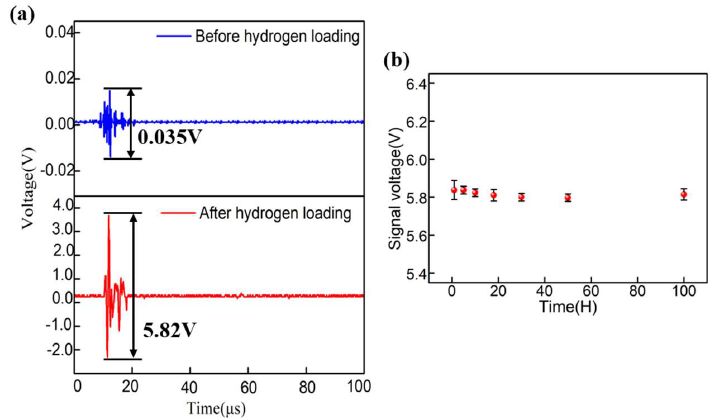
Figure 8. ( a ) Response to a 1-MHz pulse acoustic wave of sensor and ( b ) stability test of the sensor.